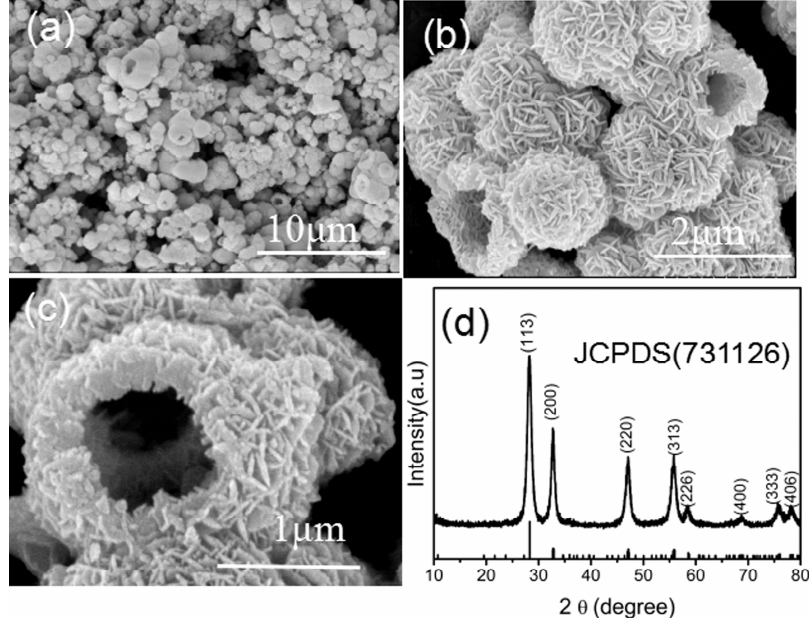
Figure 1. ( a ) A general view; ( b , c ) higher magnification field emission scanning electron microscopy